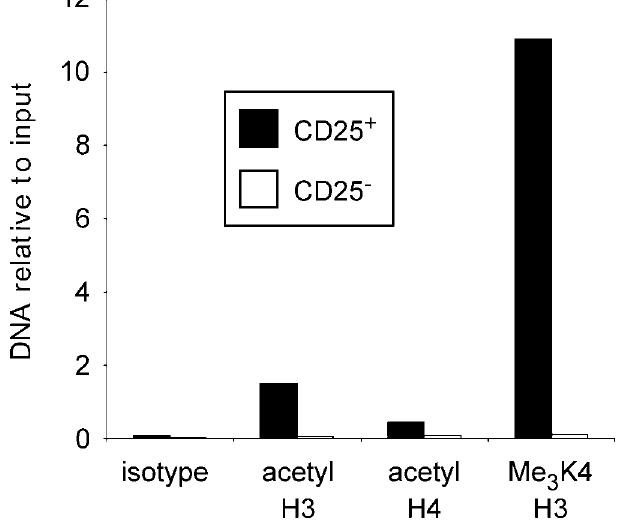
Figure 4. Increased Histone Acetylation and K4 Trimethylation in CD25 þ CD4 þ Tregs ChIP assays were performed with CD25 þ CD4 þ Tregs (filled bars) and conventional CD25 (cid:1) CD4 þ T cells (open bars) sorted from spleens and LNs pooled from 20 male BALB/c mice. DNA fragments binding to acetylated or trimethylated histones were immunoprecipitated using antibodies directed against acetylated histone H3, acetylated histone H4, or trimethylated histone H3 at position K4. A rabbit isotype immunoglo- bulin G (IgG) served as control. Precipitated DNA was quantified by real- time PCR with primers specific for the differentially methylated region of the foxp3 locus. Sample PCR products were set in relation to input DNA. One representative experiment out of two individual experiments is shown.